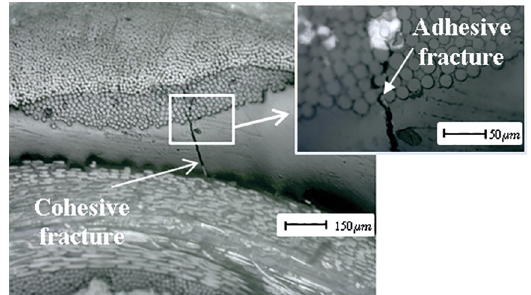
Figure 9. Uniaxial tension - fracture characteristics -